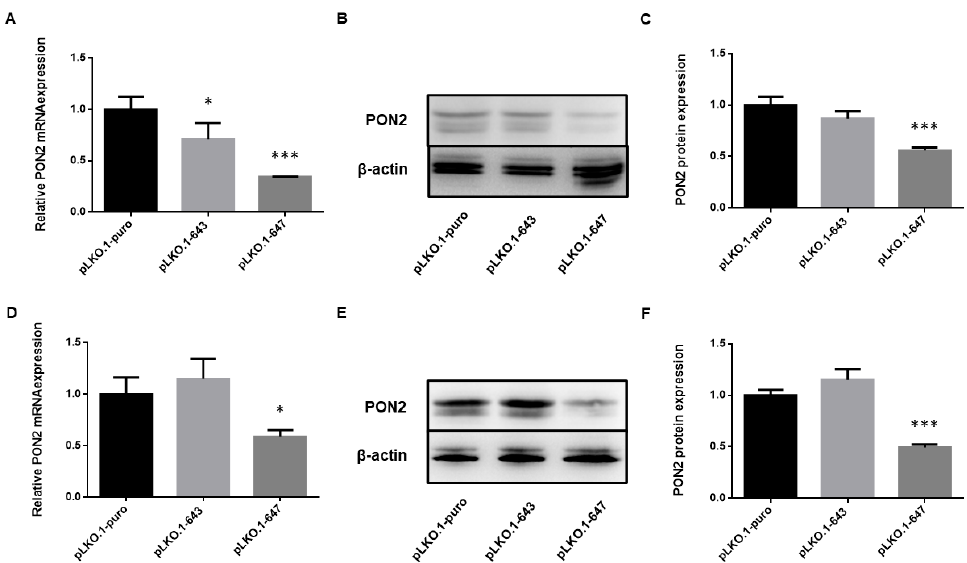
Figure 1. Evaluation of PON2 silencing in OSCC cell lines. HSC ‐ 3 ( A – C ) and HOC621 ( D – F ) cells were transfected with plasmids coding shRNAs targeting PON2 (pLKO.1 ‐ 647 or pLKO.1 ‐ 647) and with empty vector (pLKO.1 ‐ puro). Enzyme expression was then evaluated at mRNA and protein level, by Real ‐ Time PCR ( A , D ) and Western blot ( B , E ), followed by densitometry ( C , F ). Values are expressed as mean ± standard deviation (* p < 0.05; *** p < 0.005).